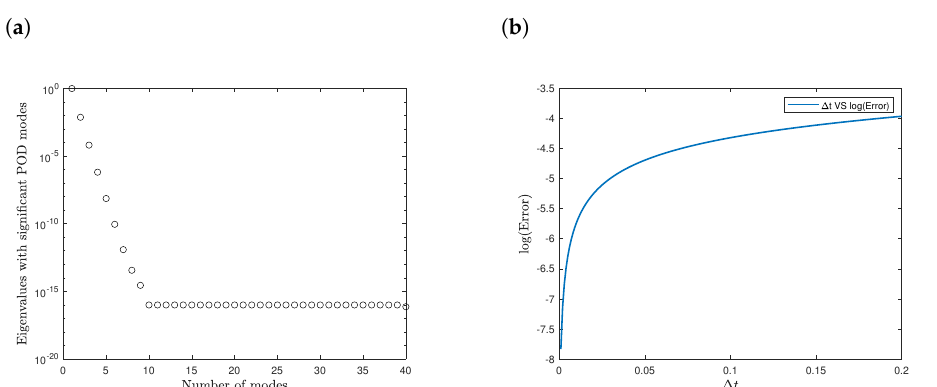
Figure 7. ( a ) Significant POD modes against number of modes. ( b ) Absolute error between the exact solution and EUPFD solution against time.